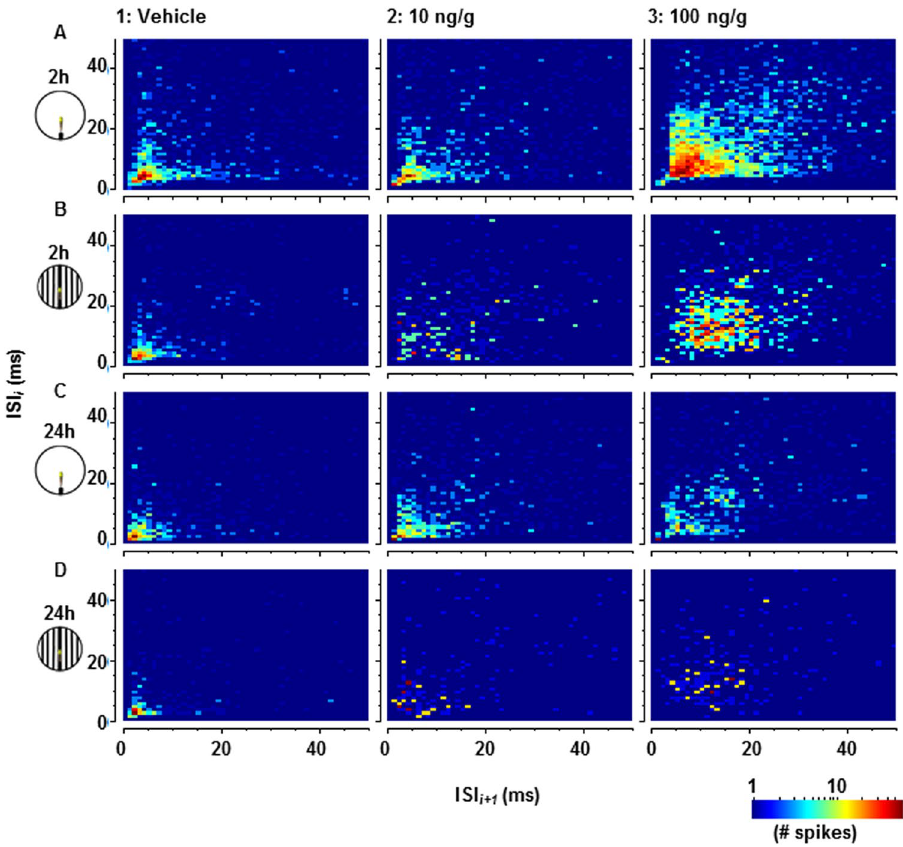
Figure 3. Joint inter-spike interval (ISI) distribution heatmaps comparing one ISI (y-axis, ms) with the following ISI (x-axis, ms). Heatmaps in column 1 were compiled from 5 stimulus presentations per animal either before treatment (1A,B, n = 25), or 24 hours after treatment with the vehicle (1C,D, n = 10). 2–3A,B were recorded from 80 to 110 minutes after treatment with 10 ng/g (n = 5) or 100 ng/g (n = 20) IMD. 2–3C,D were recorded 24 hours after treatment with 10 ng/g (2C,D, n = 10) and 100 ng/g (3C,D, n =